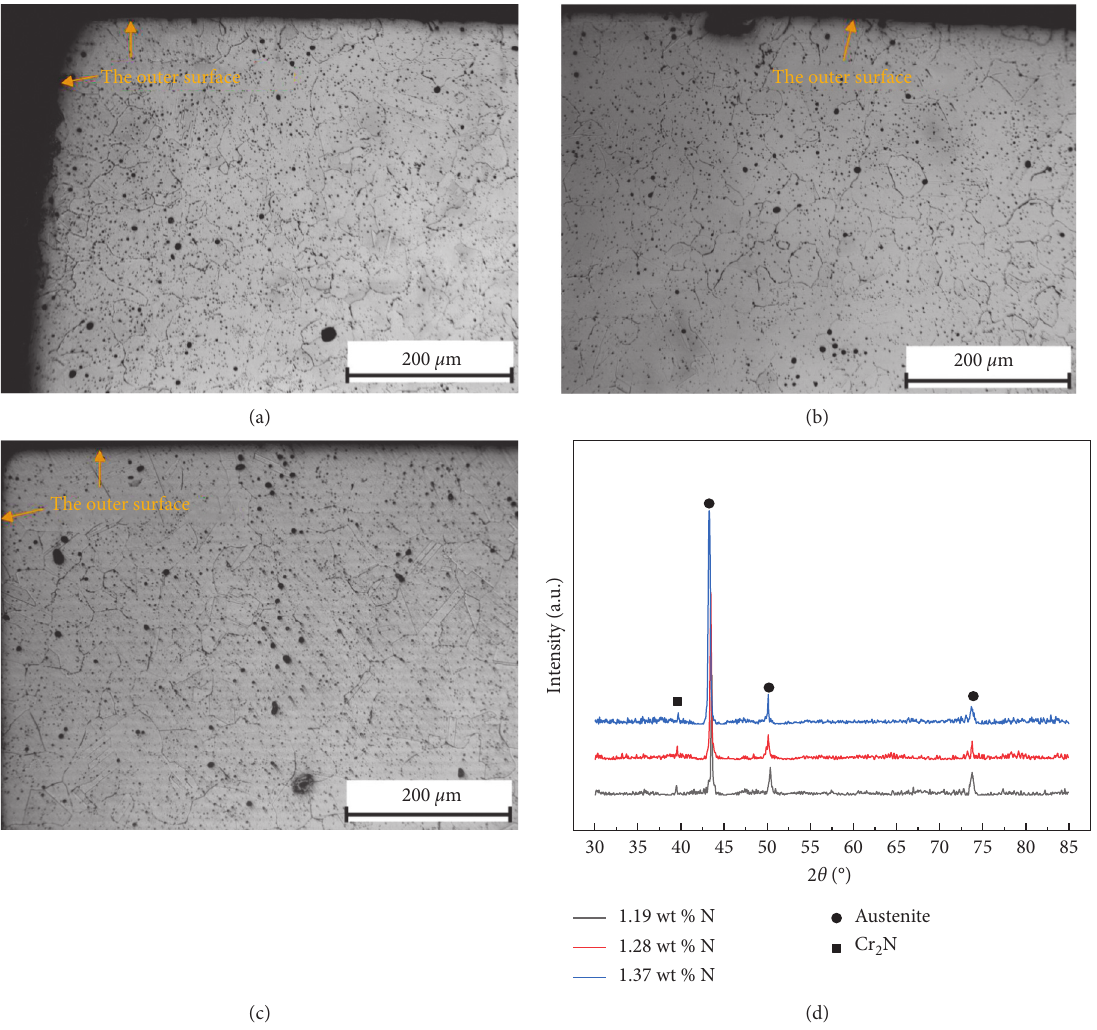
Figure 3: Metallographic structures of the solid-solution alloys with (a) 1.19 wt.% (N), (b) 1.28 wt.% (N), (c) 1.37 wt.% (N), and (d) their XRD patterns.